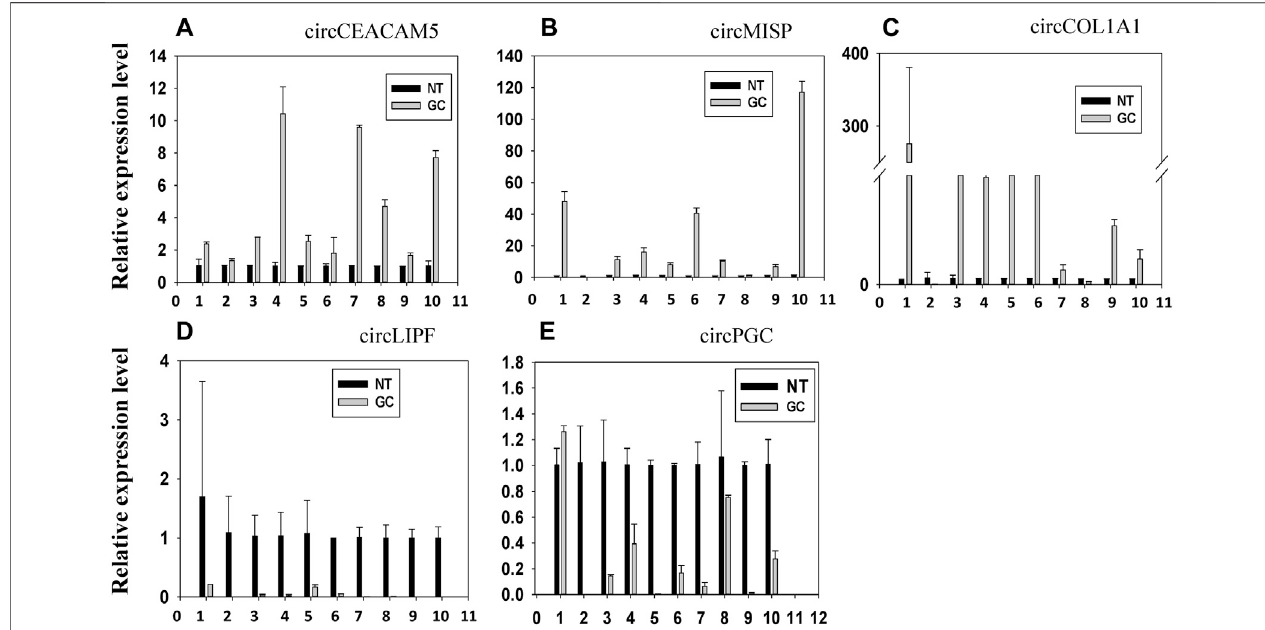
FIGURE 9 | The relative expression level of top 5 up and downregulated circRNAs. The expression of (A) circCEACAM5, (B) circMISP, (C) circCOL1A1, (D) circLIPF and (E) circPGC in 10 paired gastric cancer (GC) specimens and the corresponding paired normal adjacent tissues (NT) was determined using real-time quantitative RT-PCR with divergent